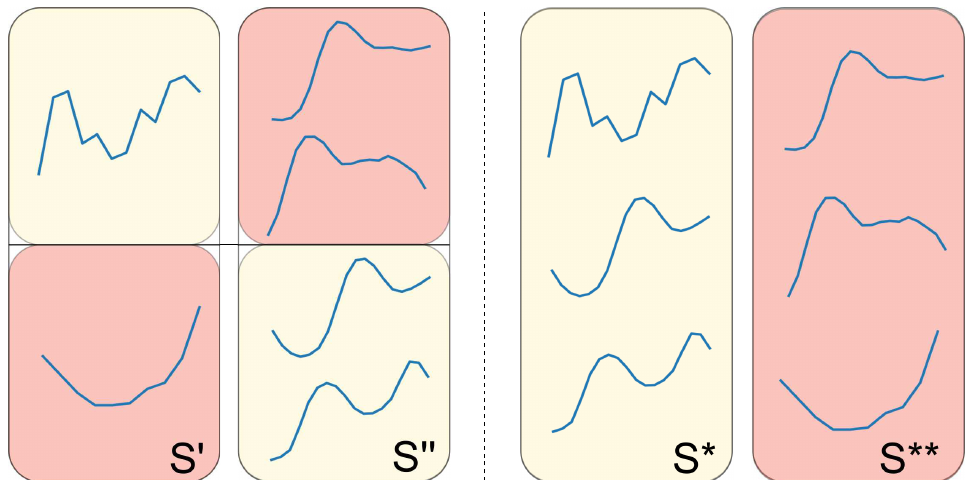
Figure 3. An example of a one-point crossover operation on two shapelet sets.